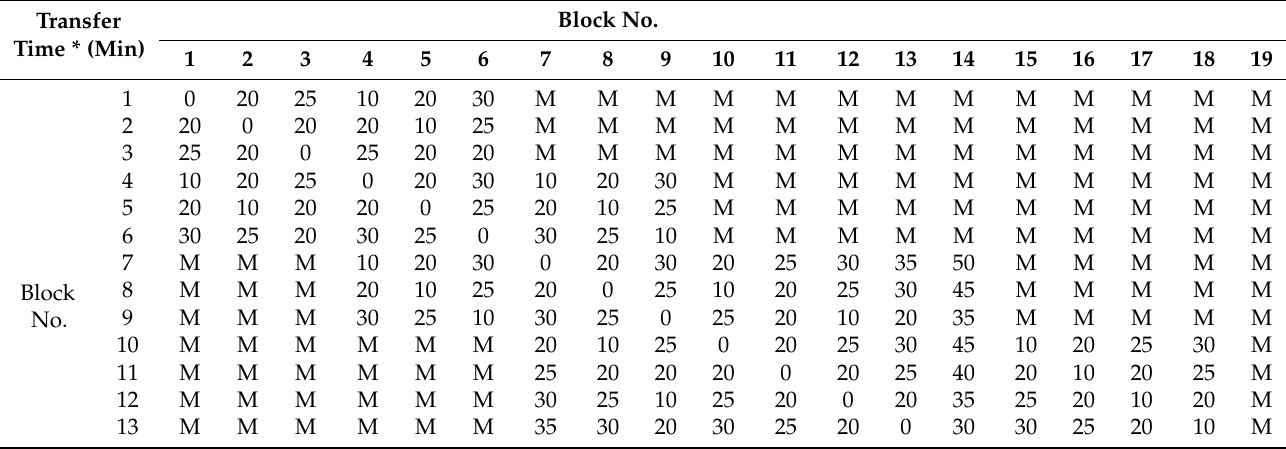
Table A1. The Transfer Time Required for RTGC to Move from one Block to